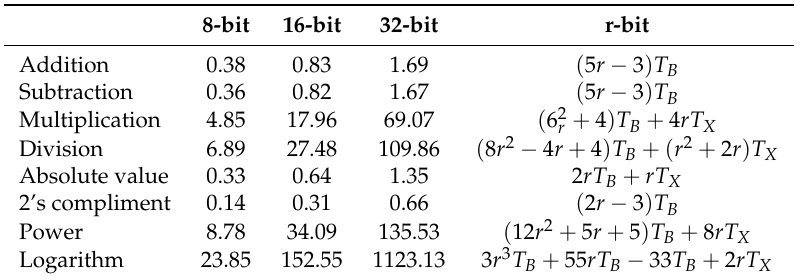
Table 2. Execution time (sec) and time complexity of homomorphic